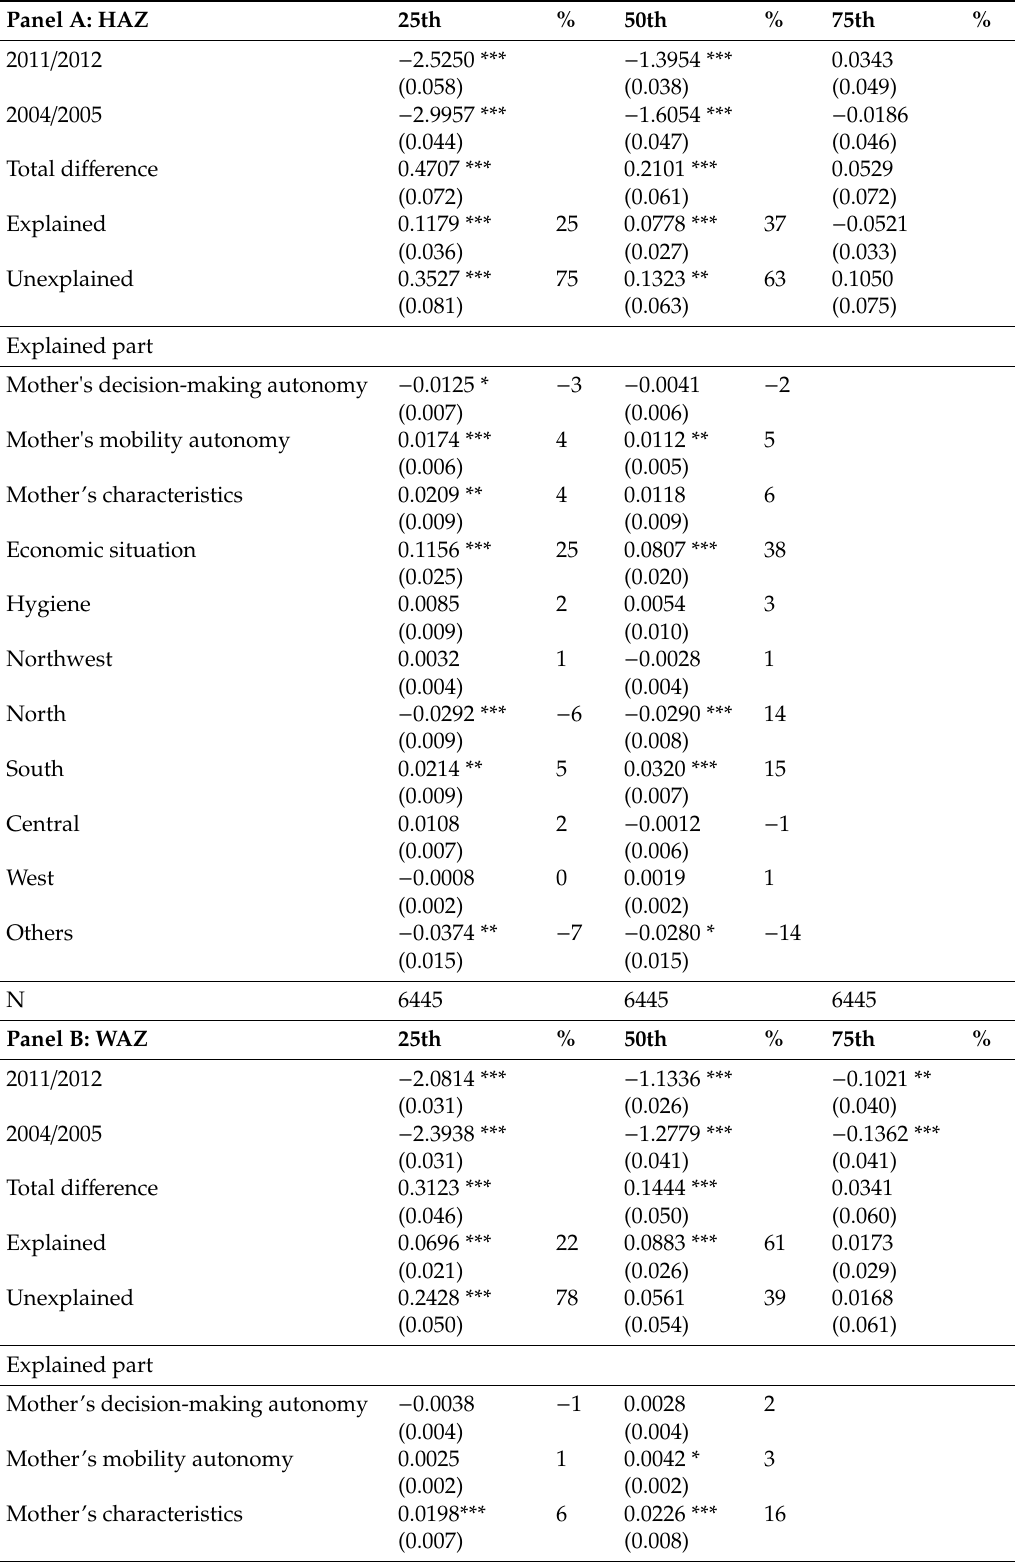
Table 4. RIFR decomposition of socio-economic di ff erences in HAZ and WAZ among Indian children under five: IHDS 2004 / 2005–2011 / 2012. Panel A: